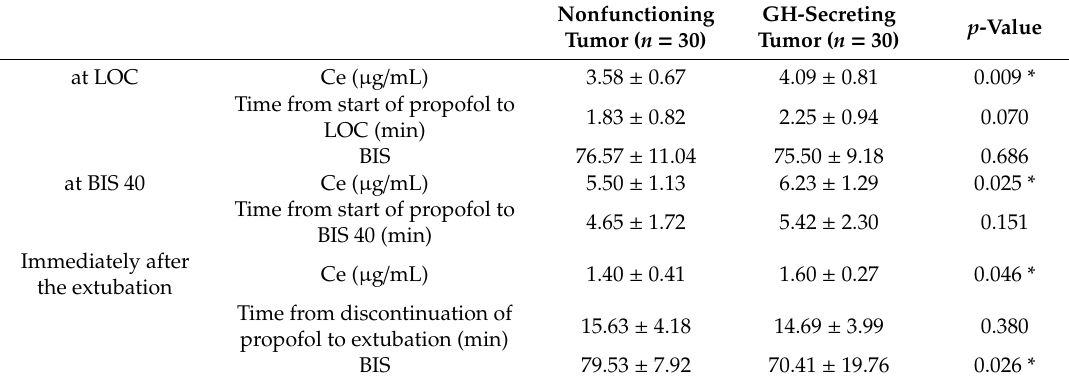
Table 2. Comparison of propofol e ff ect-site concentrations between the nonfunctioning tumor patients and the growth hormone-secreting tumor